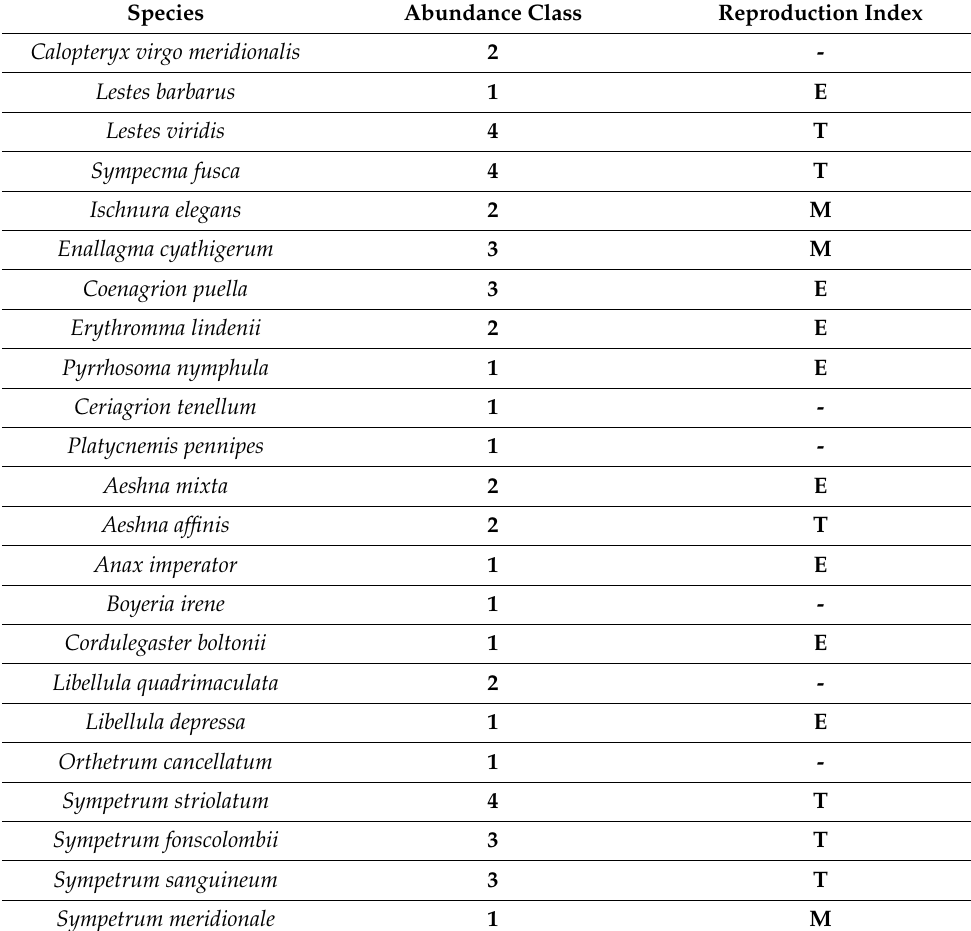
Table 1. Abundance and reproduction index of the 23 species of damselflies and dragonflies recorded in Mond é ly. Reproduction index indicates whether reproduction clues of the species were observed in the study site. For each species, we mentioned the most indicative clue of reproduction observed, using the rule teneral > egg laying > mating > no reproduction clue observed.